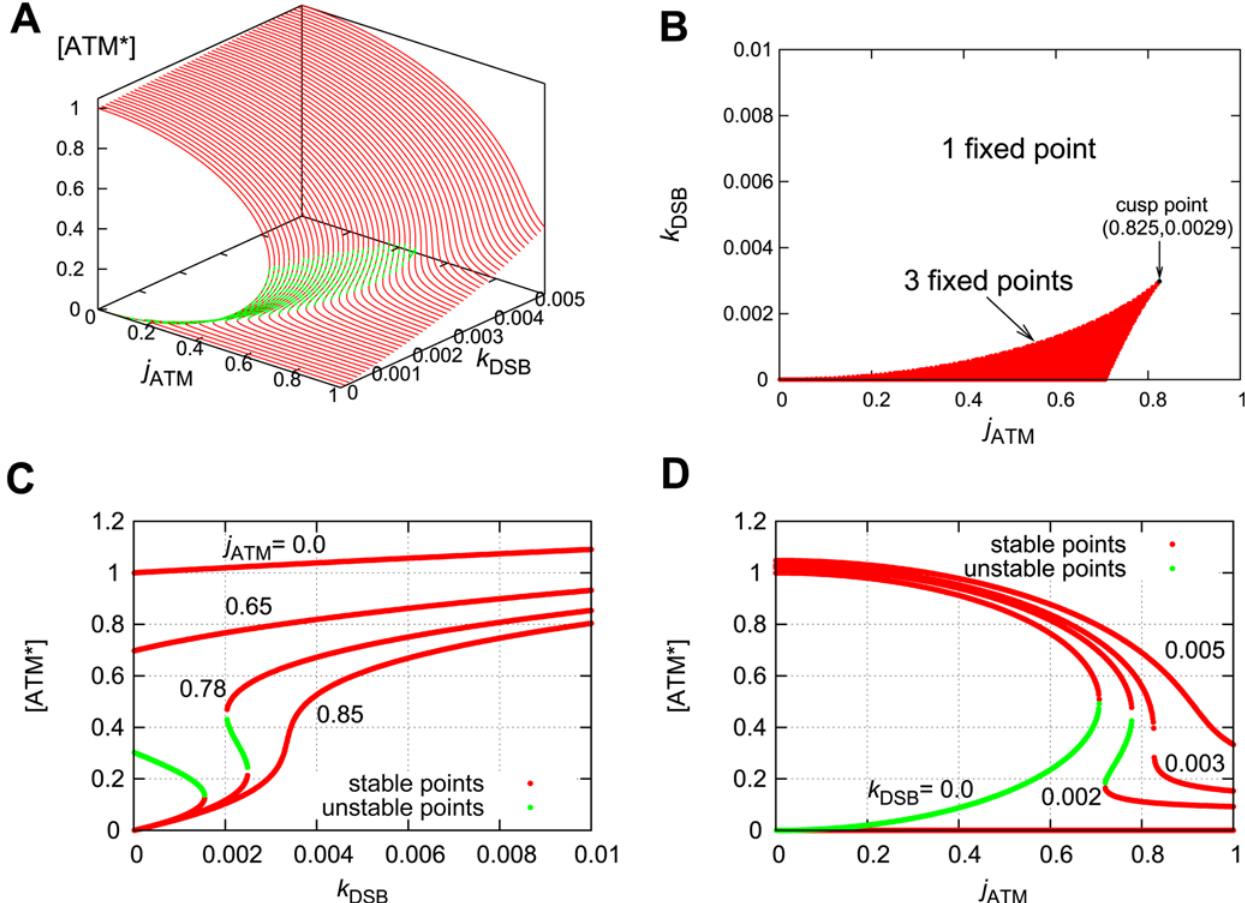
Figure 5. Bifurcation diagrams for the rate constants of k DSB and j ATM . (A) The fixed points as a function of both j ATM and k DSB . The red lines denote stable steady states, and the green lines denote unstable steady states. (B) The number of fixed points on the parameter space j ATM , k DSB ð Þ . (C) The fixed points of [ATM*] as a function of k DSB with several j ATM . (D) The fixed points of [ATM*] as a function of j ATM with several k DSB . Parameters except for j